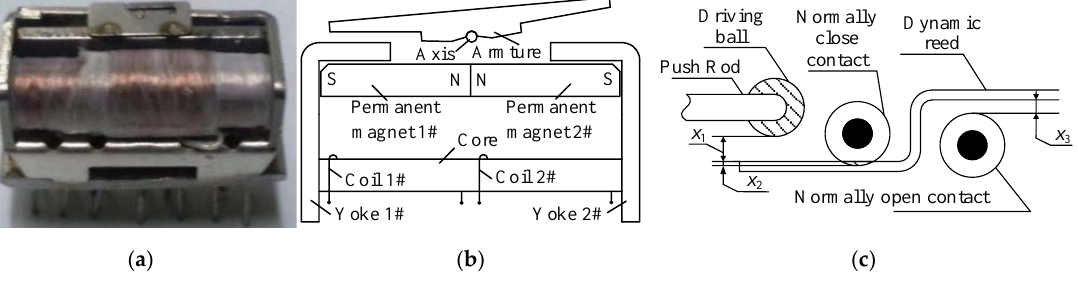
Figure 9. The rotary PMA with a double permanent magnet: ( a ) physical prototype; ( b ) electromag- netic system; ( c ) contact system.